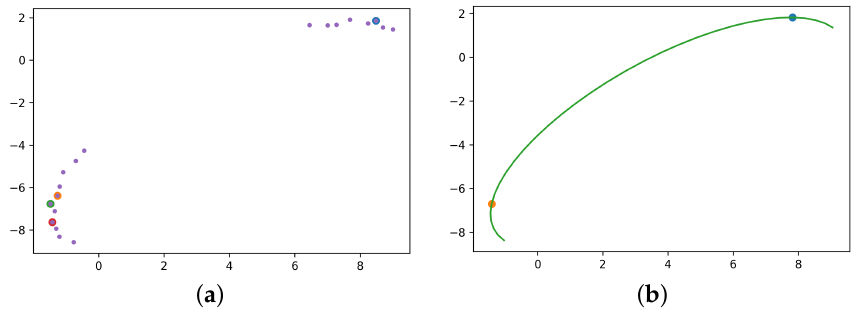
Figure 7. Dependence of the ellipse regression on the localization of the part observed and points obtained. True values of a model ellipse are: x 0 = 4; y 0 = − 3.5; a = 7; b = 3; θ = 0.7854 ( π /4) while ( a ) to ( c ) represent fitted parameters, namely: ( a ) x 0 = 4.06; y 0 = − 3.51; a = 7.07; b = 3.06; θ = 0.757; ( b ) x 0 = 0.33; y 0 = − 4.89; a = 3.85; b = 0.98; θ = 1.066; ( c ) x 0 = 4.01; y 0 = − 3.51; a = 7.0; b = 3.01; θ = 0.767.